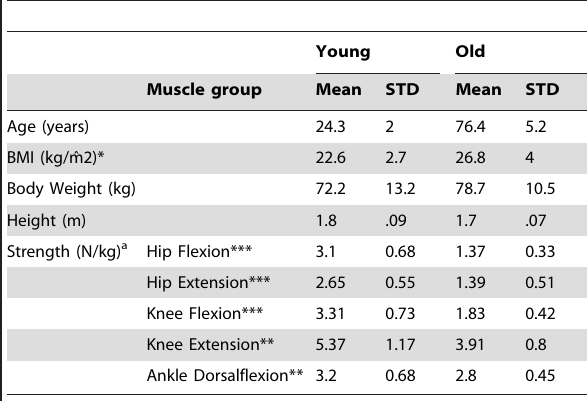
Table 1. Anthropometric data and strength measurements of young and old